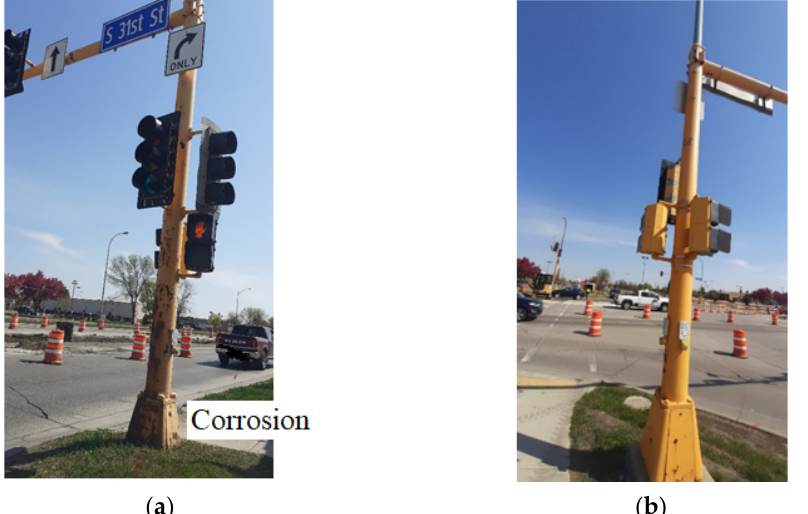
Figure 1. Images of existing traffic poles ( a ) exhibiting significant corrosion; ( b ) without major cor- rosion.